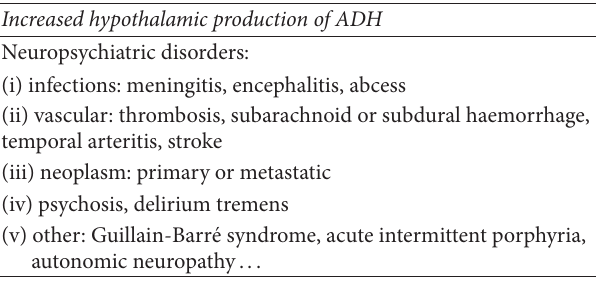
Table 1: Most common causes of